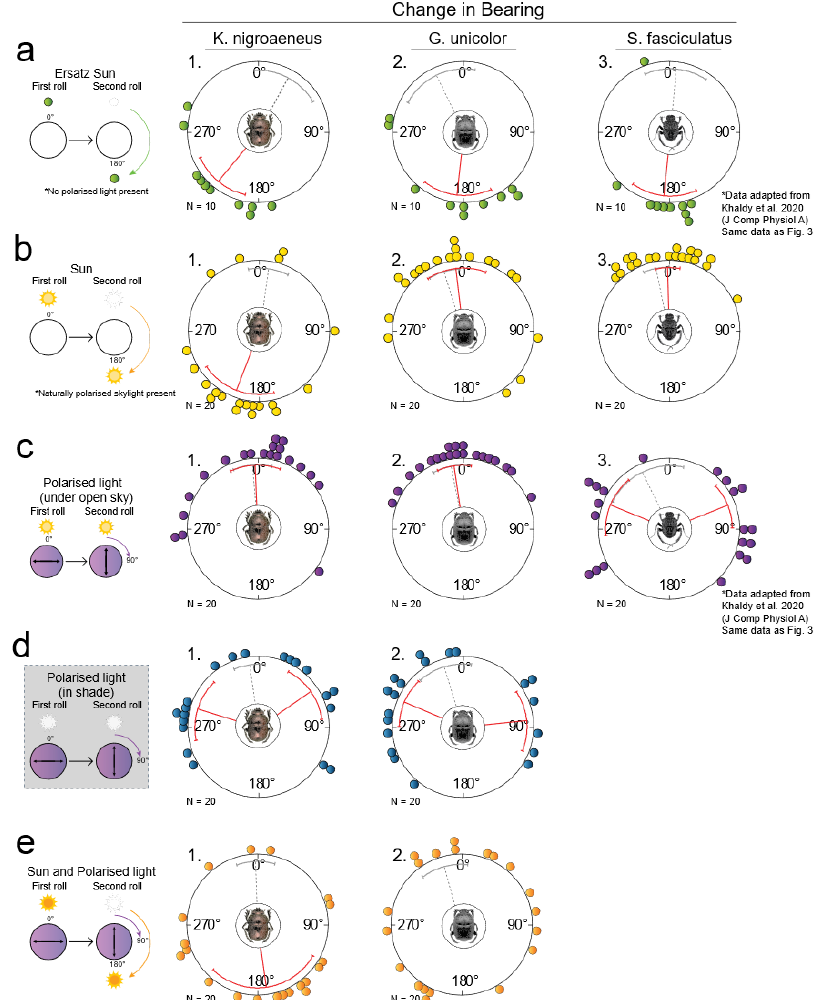
Figure 3. Response to directional change of compass cues. Three diurnal dung beetle species (from left to right; Kheper nigroaeneus , Garreta unicolor and Sisyphus fasciculatus ) were allowed to roll balls out of a circular arena in a darkened room ( a ) or outdoors under the open sky ( b ), or with a polarisation filter placed above the arena with the sun visible ( c , e ) or with a polarisation filter placed above the arena with the sun shielded from view ( d ). Once the beetle had reached the periphery of the arena, it was removed from its dung ball and placed back in the centre alongside its ball. At this time, the apparent position of the ersatz sun (( a ), green arrow ) or the real sun (( b ), orange arrow ) was switched by 180 ◦ , the apparent e-vector direction was turned by 90 ◦ using a polarisation filter (( c , d ), purple arrow ) or the position of the sun was changed by 180 ◦ while simultaneously turning the apparent e-vector direction by 90 ◦ (( e ), orange arrow: sun; purple arrow : polarisation filter). The beetle was then allowed to exit the arena a second time. The absolute angular difference between the first and the second exit angle represent the response to the treatment ( test ). ( a ): With the ersatz sun switched by 180 ◦ , all three species changed their bearings in accordance with this angular change (red vector, all graphs); ( b ): with the sun mirrored by 180 ◦ outdoors, only K. nigroaeneus showed a significant change in bearings in response to this manipulation; ( c ): with the e-vector turned by 90 ◦ under a clear sky, only S. fasciculatus responded significantly by a change in exit bearings approaching 90 ◦ ; ( d ): with the sun shielded from view, a significant change in bearings could also be elicited in K. nigroaeneus and G. unicolor ; ( e ): with the sun mirrored by 180 ◦ and the polarisation pattern e-vector turned by 90 ◦ , K. nigroaeneus changed its exit bearings in a similar fashion to when only the sun was mirrored by 180 ◦ (see graph 1 in ( b )), while the changes in exit bearings for G. unicolor were randomly distributed within the population (graph 2). Beetles were then allowed to roll a third time, with the manipulated cue(s) moved back to its/their initial position. The mean angular difference between the first and second exit ( test ), and the first and third exit ( control ), is represented by a red solid vector and a grey dotted vector, respectively, in each graph. Error bars represent one circular standard deviation. The data presented for S. fasciculatus in ( a ) and ( c ) (graph 3, respectively) were adapted from Khaldy et al., 2020 [26]. For detailed data see Supplementary Table